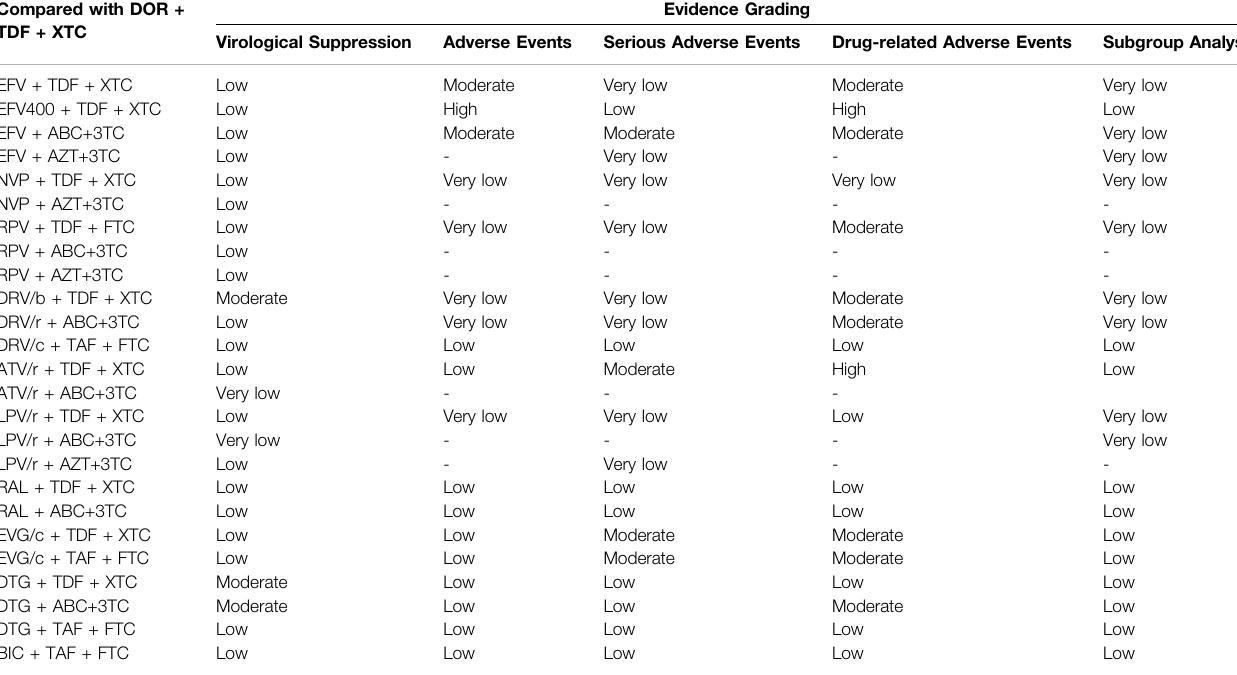
TABLE 3 | CINeMA evidence